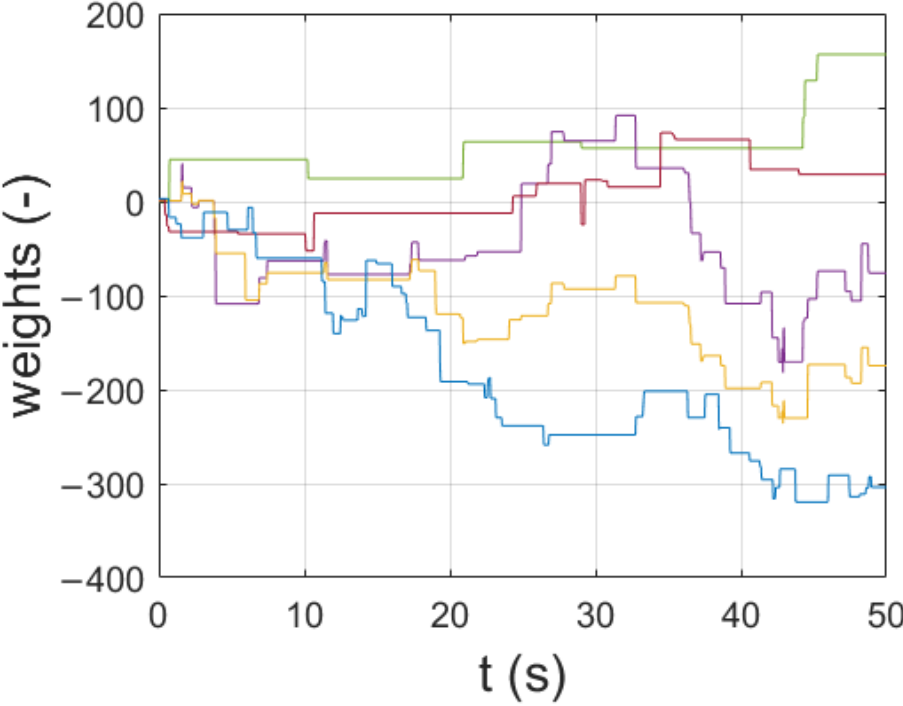
Figure 17. Transients of the RBFNN weights—experimental